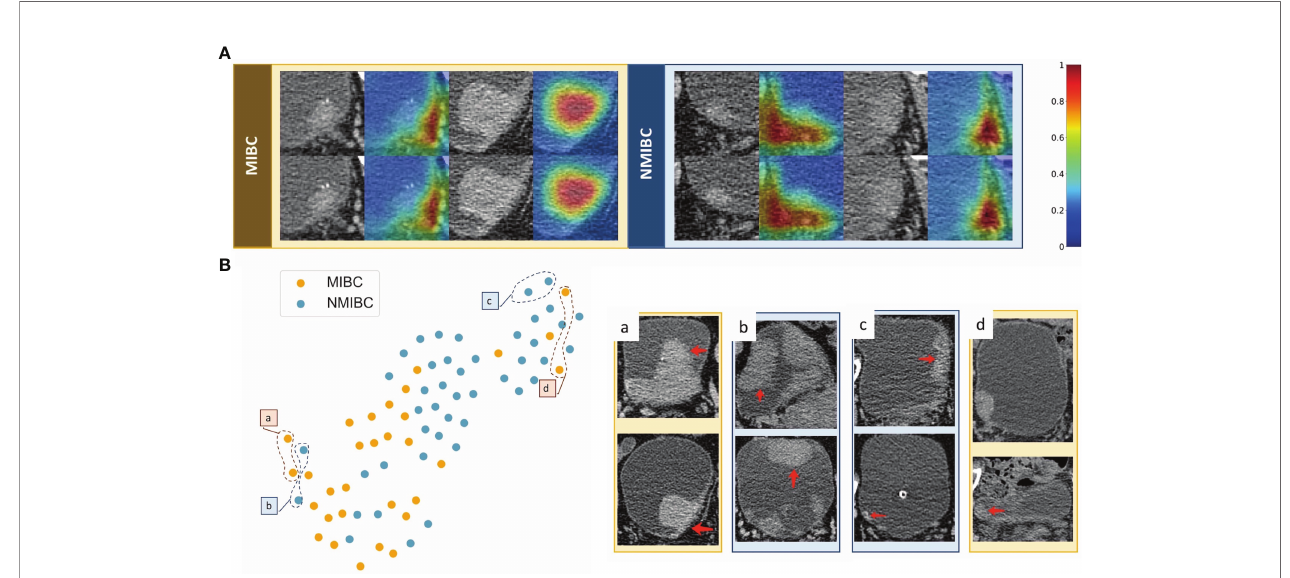
FIGURE 5 | Examples of feature maps from validation cohorts and visualization of the effectiveness of the learned features. (A) Two cases from MIBC and two cases from NMIBC are shown. The active regions were mainly overlaid on the areas with visual characteristics that were helpful for discriminating between MIBC and NMIBC, including the internal region of the tumor, corresponding bladder wall, and the surrounding outside pelvic fat. (B) Colored points represent the NIMBC (blue) and MIBC (orange). Effective features were learned by the model, and the two categories of nodules were well clustered. The eight examples show images corresponding to circled points. Nodules in sets a and c were highly discriminated by the model, whereas nodules in sets b and d were less discriminated because they shared similar features with the opposite